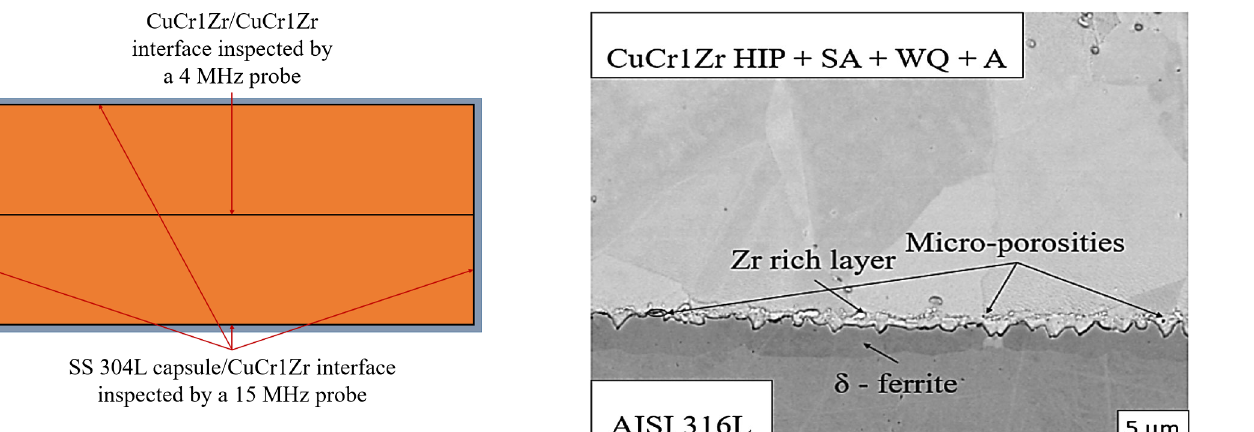
FIG. 6. Interfaces inspected by ultrasounds after HIP cycle.